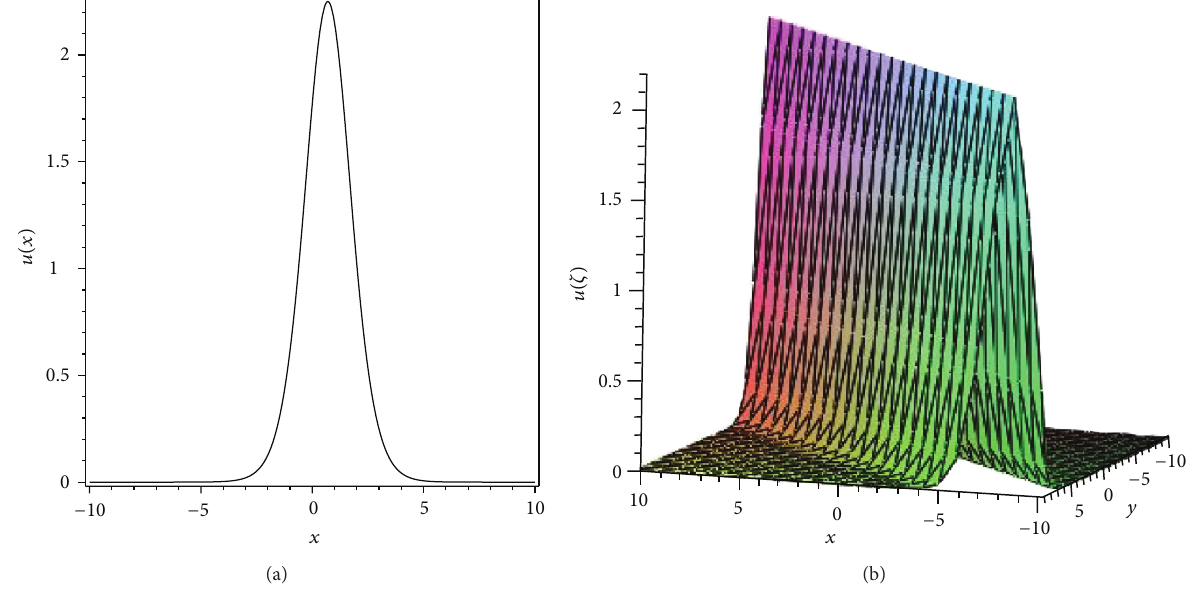
Figure 2: Bell type solitary (a) 2D profile and (b) corresponding 3D plot of (47) for parameters 𝛼 = 2 , 𝛽 = 0.4 and 𝛿 = 0.1 , 𝜆 = 1 , 𝑘 = 1 , and 𝑡 = 0.5